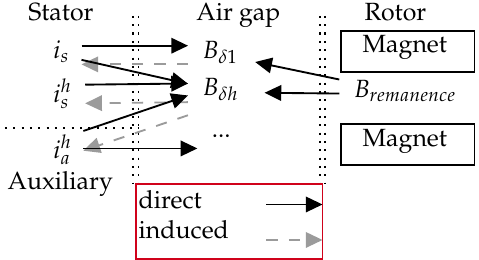
Figure 3. Interactions between the stator and